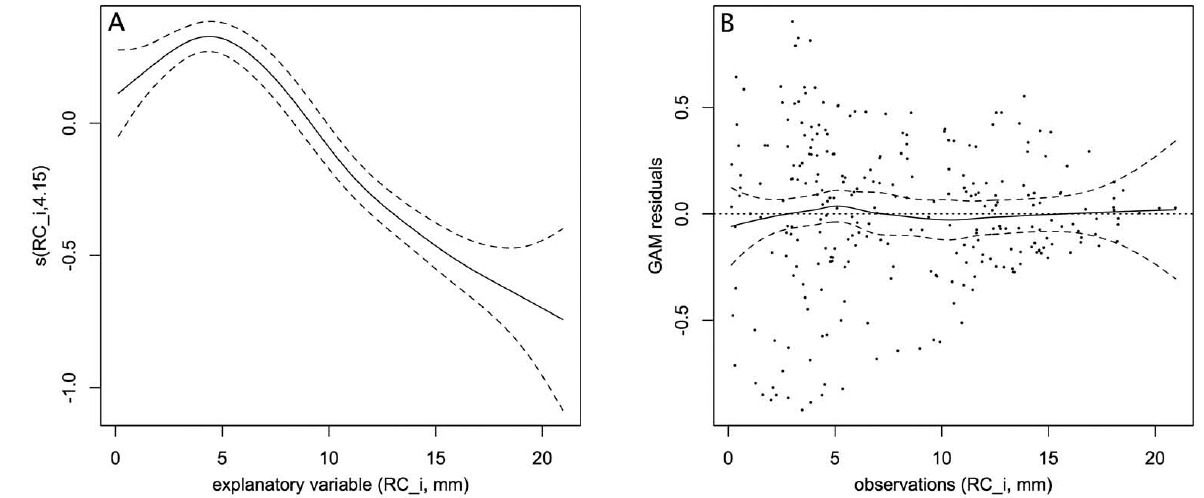
Fig. 4. – Generalized additive model (GAM) validation plots. A) smoothing function; B) standardized residuals for the optimal GAM plot- ted against observations. Loess fit predictions for mean (span 0.65; solid black line) and 95% confidence intervals (dashed black lines) are superimposed on the observed data (black dots), showing no residual